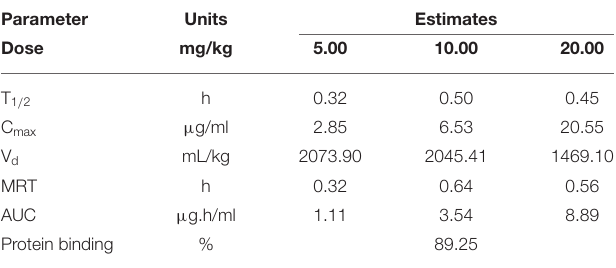
TABLE 3 | Parameter estimates from PK analysis of free-serum NZX concentrations after single intravenous administration of an NZX dose of 5 to 20